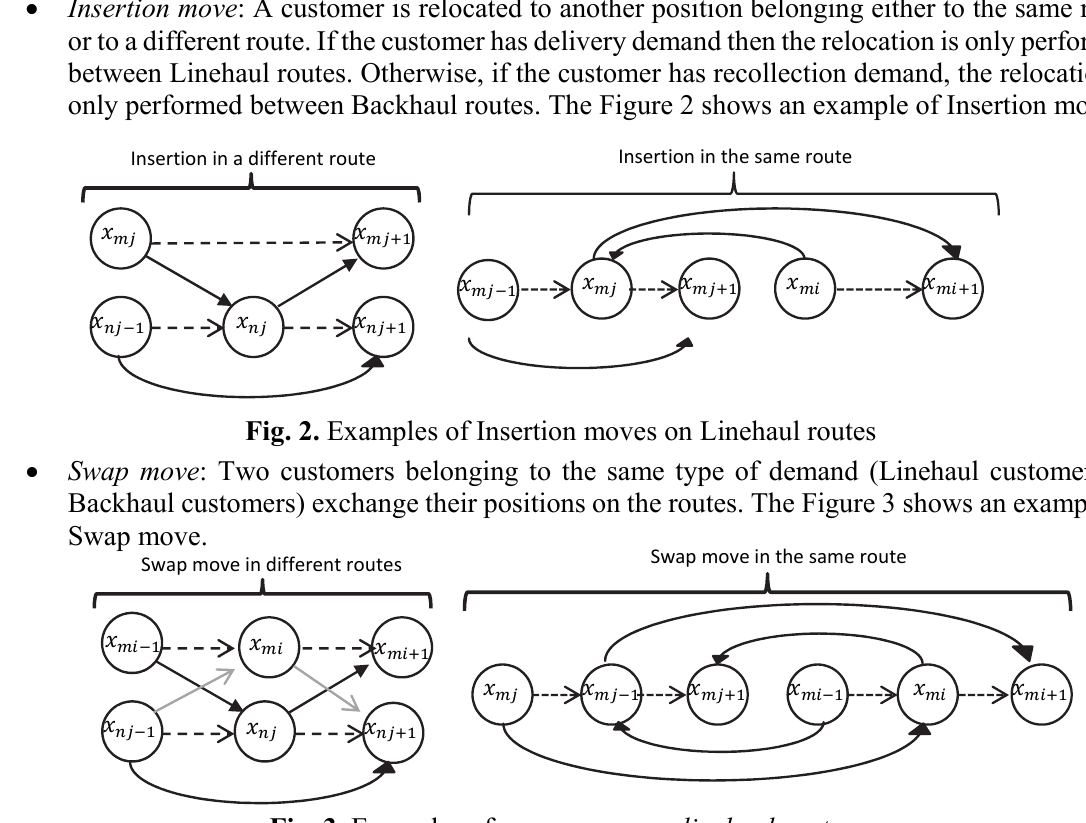
Fig. 3. Examples of swap moves on linehaul